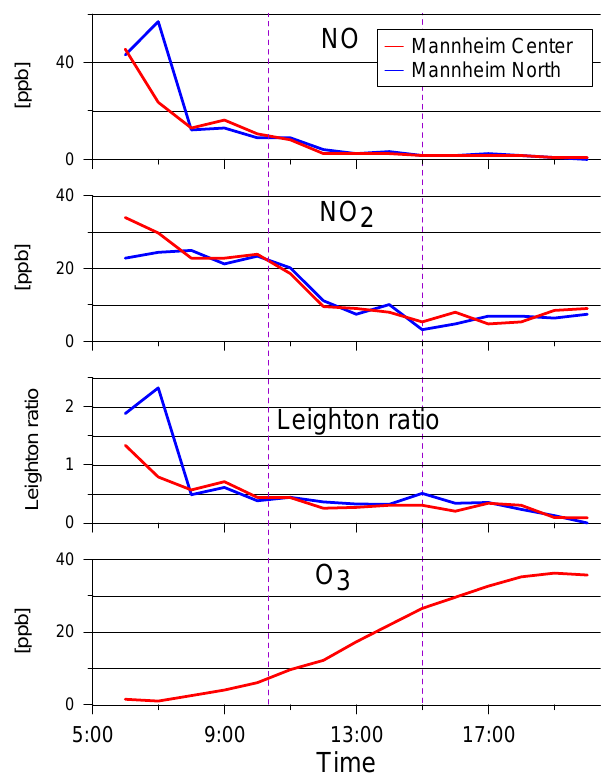
Fig. 7. Diurnal variation of the mixing ratios of NO, NO 2 , and O 3 Fig. 7 Diurnal variation of the mixing rations of NO, NO 2 , and O 3 for the stations Mannheim for the stations Mannheim North and Mannheim center on 24 Au- North and Mannheim center on 24.08.2006. Also the Leighton ratio is shown. The dashed gust 2006. Also the Leighton ratio is shown. The dashed vertical vertical lines indicate the start and end times of the car MAX-DOAS measurements. lines indicate the start and end times of the car MAX-DOAS mea-